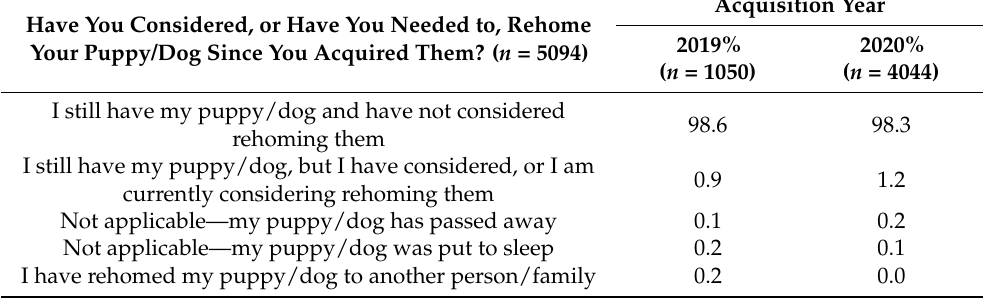
Table 13. Comparison of owner reported relinquishment or considered relinquishment between 2019 puppies ( n = 1050) and Pandemic Puppies ( n = 4044). The answer options listed represent all the choices available to